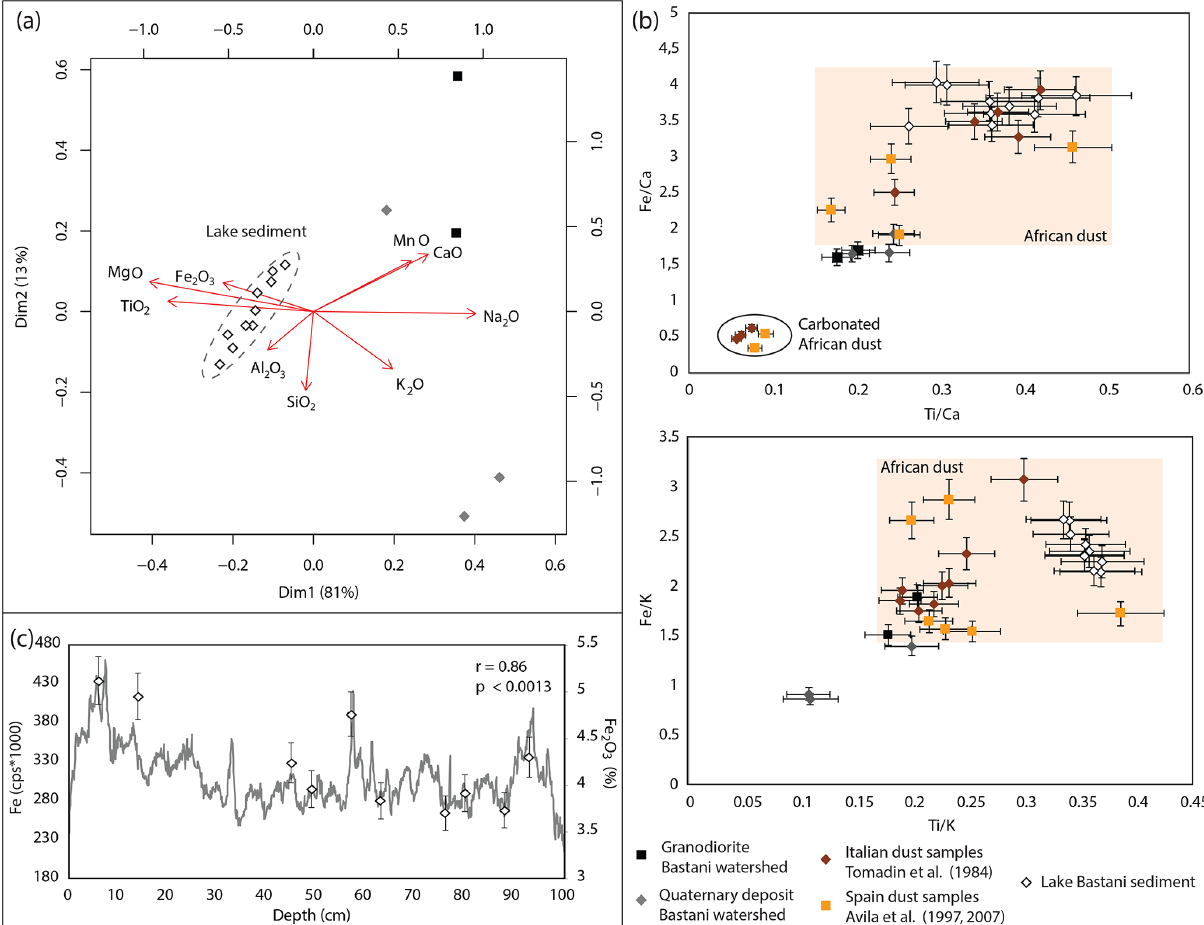
Figure 2. (a) PCA biplot of major elements obtained by ICP-MS measurement corrected for LOI content and after centered log-ratio trans- formation. Data used in this PCA are from both lake sediment (dotted area) and watershed samples (granodiorite and quaternary deposits). (b) Selected element ratios (Fe / Ca vs. Ti / Ca and Fe / K vs. Ti / K) from ICP-MS measurement on lake sediment, watershed samples, and data from dust deposits in the NW Mediterranean (Spain; Avila et al., 1997, 2007) and central Mediterranean areas (Adriatic Sea, Italy, Sicily; Tomadin et al., 1984). Light orange areas correspond to the geochemical signature of African dust from the available dataset. (c) Comparison between Fe content from the XRF core scanner and ICP-MS